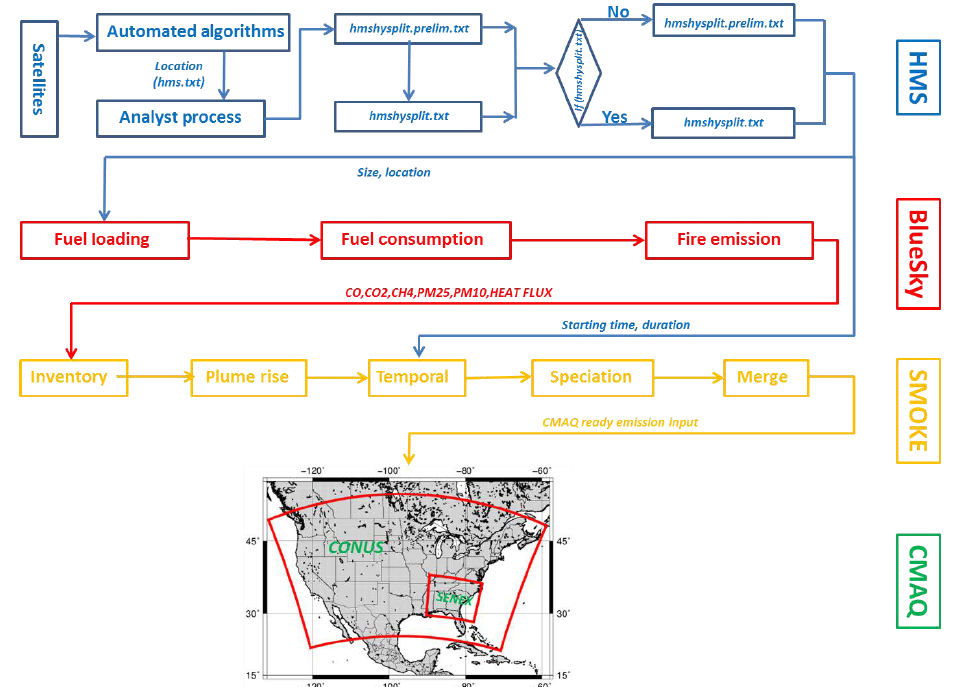
Figure 1. Schematics of fire emission and smoke plume simulation system used: data feed and/or modeling of physical and chemical processes were handled largely sequentially from top to bottom and from left to right. The right-hand four vertical boxes depict the submodel names: NESDIS Hazard Mapping System (HMS) for wildfire hotspot detection; the US Forest Service’s BlueSky for fuel type and loading parameterization; the US EPA’s Sparse Matrix Operator Kernel (SMOKE) for handling emission characterization; and lastly the Community Multiple-scale Air Quality model (CMAQ) for simulating the transformation, transport and depositions of the atmospheric constituents. The “SENEX” inset framed by bold red lines was the domain for this